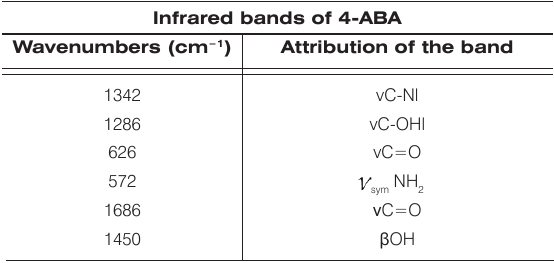
Figure 6. Chronopotentiometric curves recorded during galvanostatic electrodeposition of 4-ABA on GCE. External current densities (Acm -2 ): (a) 0.010, (b) 0.015, (c) 0.020, (d) 0.025 and (e) 0.050. Inset: of cyclic voltammetry responses recorded in 0.5 mol dm -3 K for the 4-ABA films deposited on GCE. Scan rate, 50 mV s -1 . (cm -1 ) intensities and assignments of selected bands of aromatic ring occurring in the Raman spectra of Infrared bands of 4-ABA Wavenumbers (cm −1 ) Attribution of the band